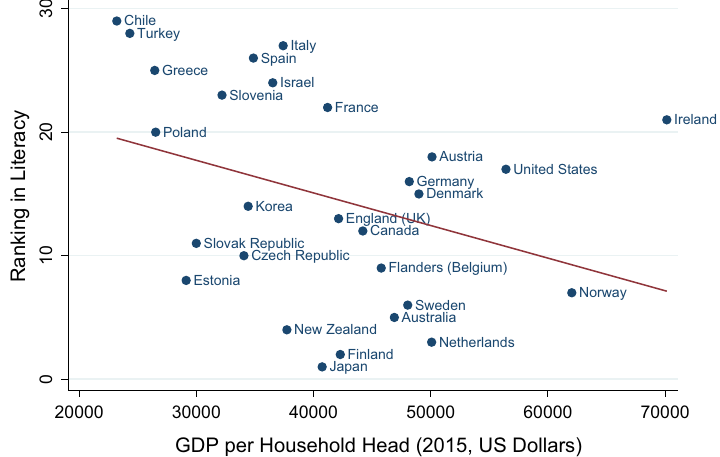
Fig. 1 GDP per capita and literacy ranking